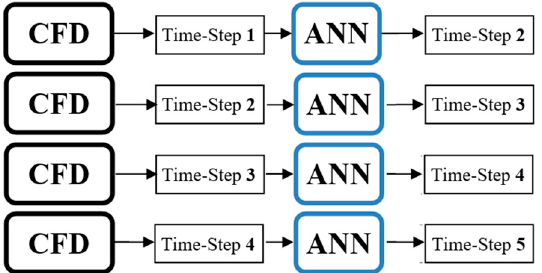
Figure 16. Non-cascading deployment process.